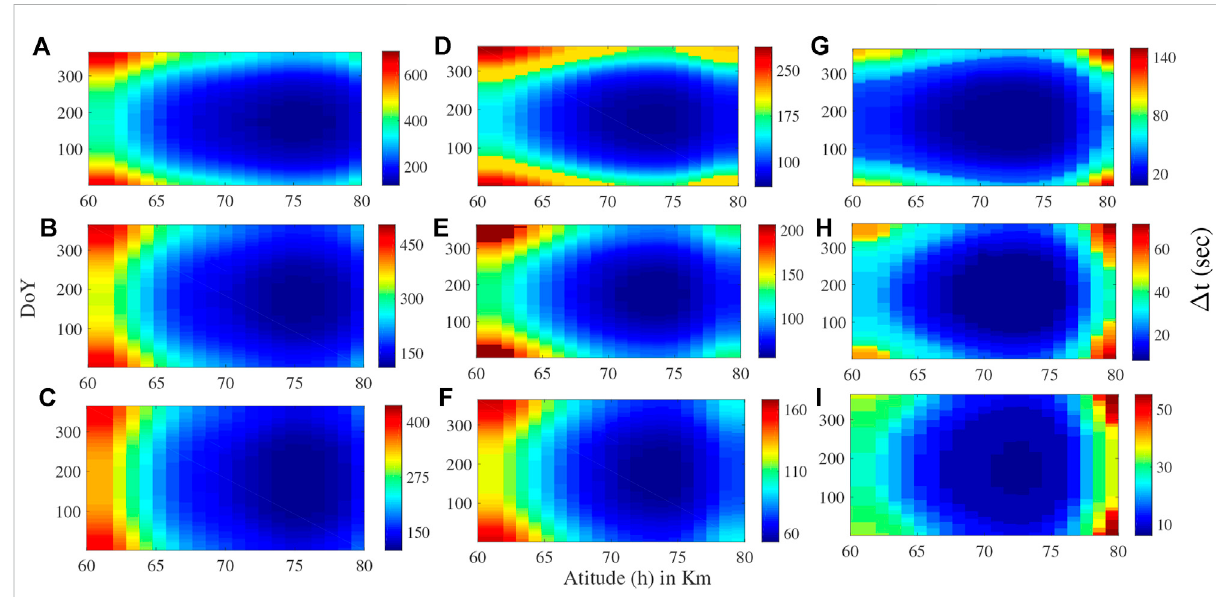
FIGURE 3 Seasonal variation of Δ t - h pro fi le for (A – C) C5.2, (D – F) M5.2 and (G – I) X2.2 classes of fl ares over N60 (A,D,G) , N45 (B,E,H) and N30 (C,F,I) respectively.